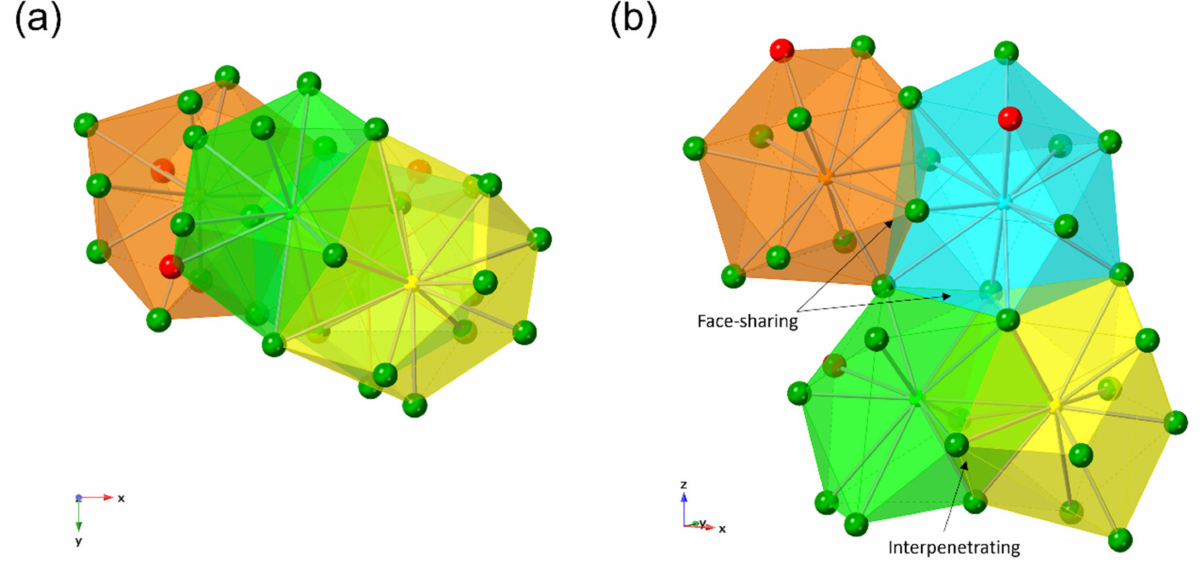
Figure 5. The aggregate of coordination polyhedra (medium range order) found in Figure 3b. The difference between ( a ) and ( b ) is the projection